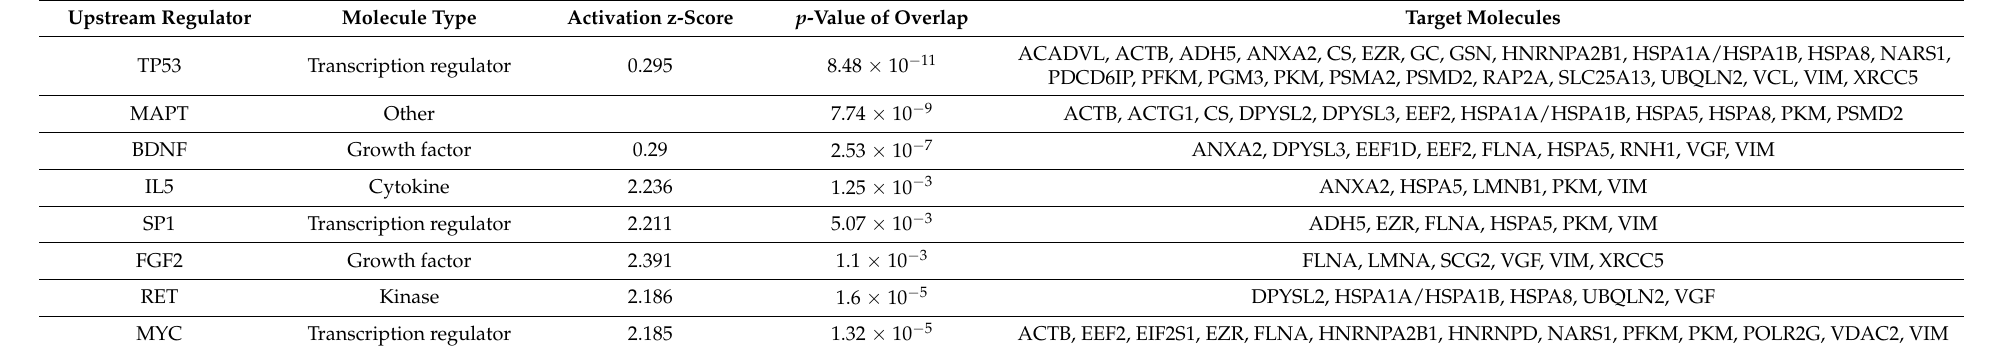
Table 6. List of top eight upstream regulators obtained by IPA analysis of differentially expressed proteins in hill extract treated SH-SY5Y